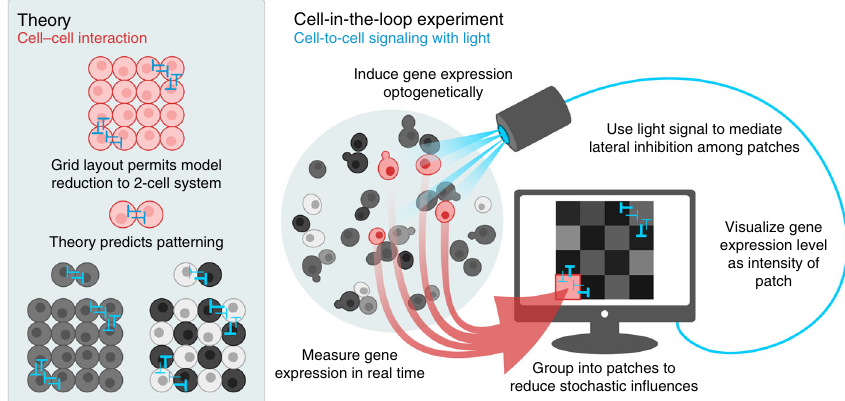
Fig. 1 Spontaneous checkerboard patterning with optogenetically emulated cell-to-cell signaling. Optogenetically responsive cells signal to each other through computer-controlled light inputs that vary in intensity based on the gene expression levels of other cells. We enact lateral inhibition according to the theory in Section 3.1 that predicts when cells will spontaneously separate into two classes of high and low gene expression. In all fi gures, red denotes in vivo and blue denotes in silico